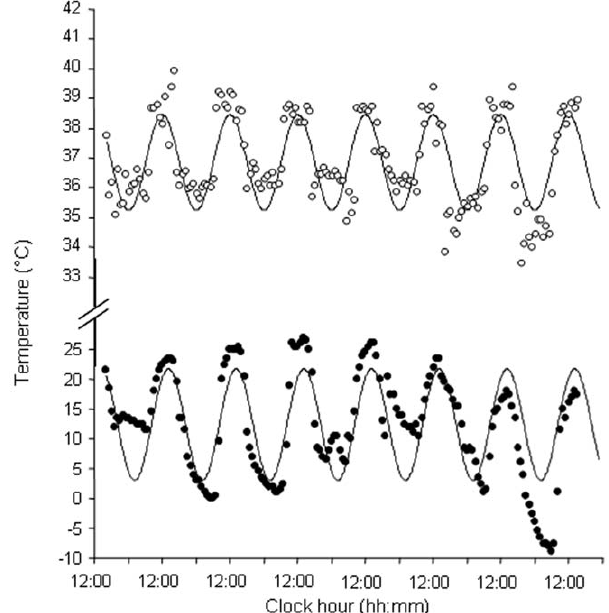
Figure 4. T b (open circles) and T a (solid circles) and fitted cosine curves for a Cape ground squirrel during the 9 th week of the sampling period illustrating the variation in T a and T b . The difference between the lowest T b value recorded (33.39 u C at 19:08) and the highest T b during the previous day (39.32 u C at 16:08) was 5.93 u C. Over the 23 week period, extreme changes in T b included one individual that decreased in T b by 5.56 u C and another that increased in T b by 5.98 u C in one hour.